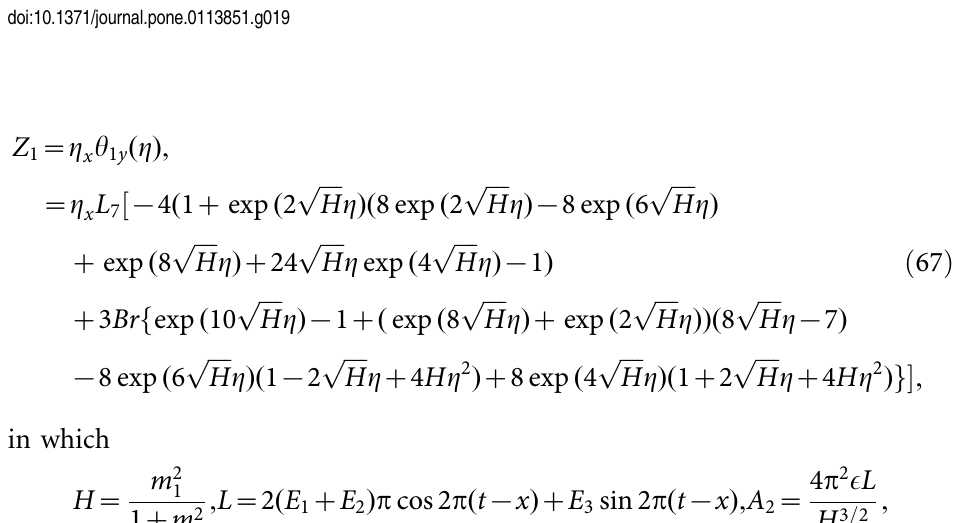
Figure 19. Plot of concentration g for Schmidt number Sc with E ~ 0 : 2 , t ~ 0 : 1 , x ~ 0 : 1 K ~ 0 : 5 and M ~ 2